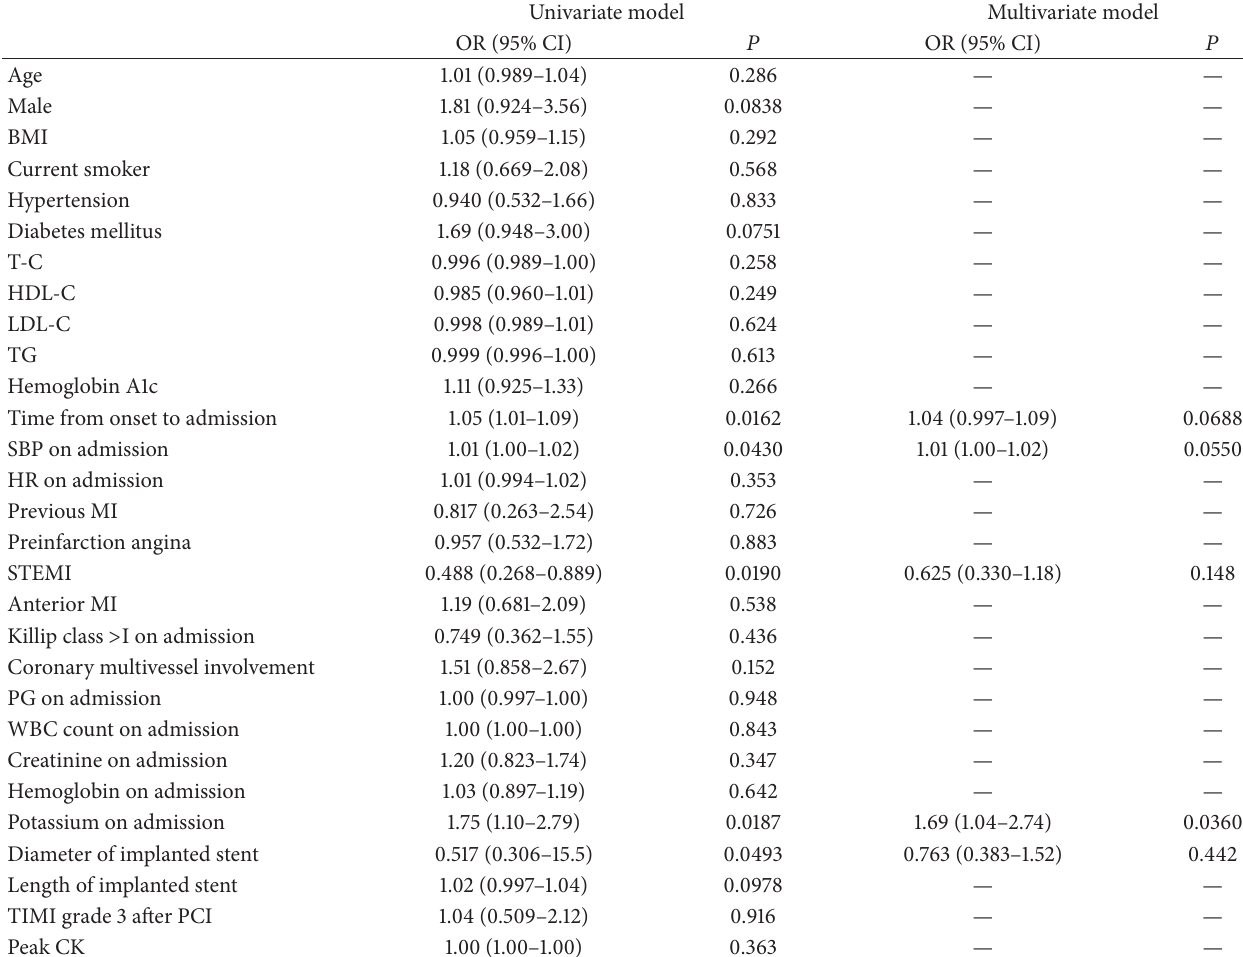
Table 4: Logistic analysis for the risk of target lesion revascularization.